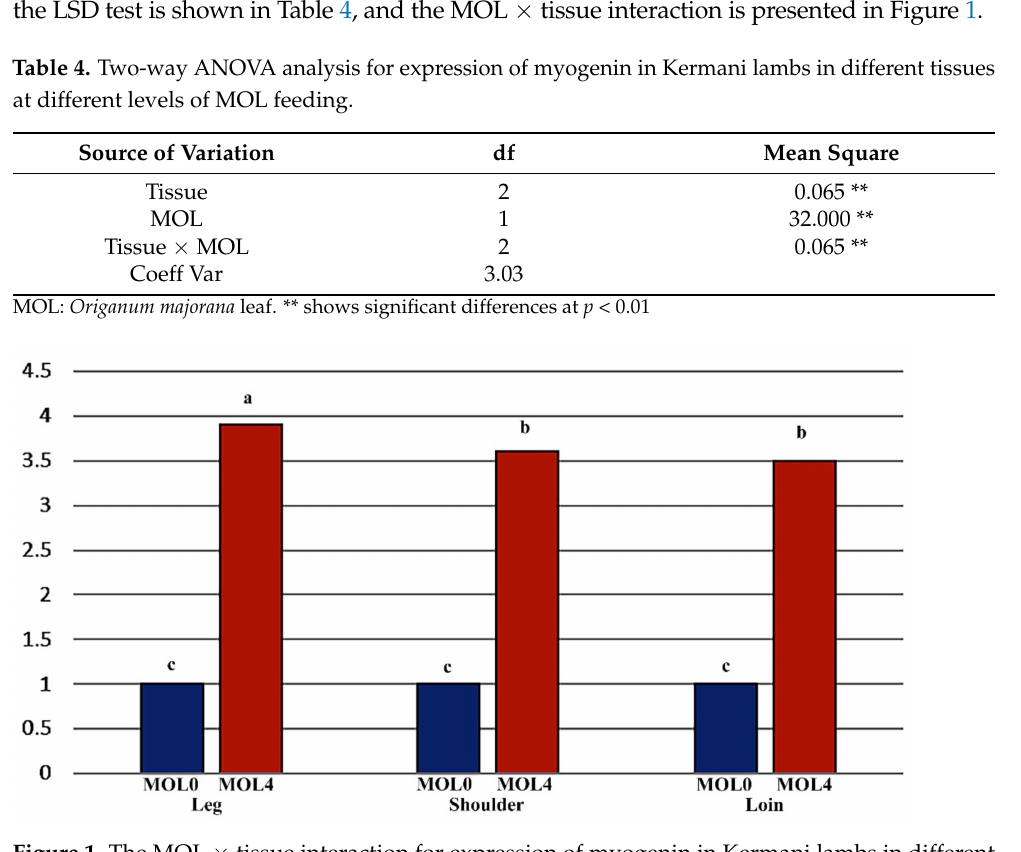
Figure 1. The MOL × tissue interaction for expression of myogenin in Kermani lambs in different tissues at different levels of MOL feeding. MOL0: 0% Origanum majorana leaf, MOL4: 4% Origanum majorana leaf. Treatments that have at least one letter in common do not differ